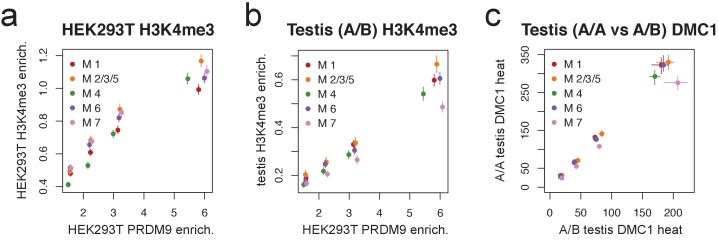
Motif 7 represents a binding mode favored by the B allele.(a) Peak enrichment quartiles (filtered to remove promoters) were separated by motif type (Motifs 2, 3, and 5 were combined due to low abundance), and mean force-called H3K4me3 enrichment was plotted against median PRDM9 enrichment in each quartile. Error bars indicate two standard errors of the mean. This shows that the lower recombination rates for Motif 7 do not result from lower histone methylation activity of PRDM9 at those sites. (b) Peak enrichment quartiles as in a, but with force-called testis H3K4me3 enrichment values from (Pratto et al., 2014) in an individual with an A/B genotype. Motif 7 shows lower testis H3K4me3 enrichment for each level of PRDM9 binding, consistent with it being bound less efficiently by the A allele. Error bars indicate two standard errors of the mean. (c) At DMC1 hotspots found in both A/A and A/B individuals (from Pratto et al., 2014), a q-q plot of reported DMC1 heats for each motif type (quantiles 0.125,0.375,0.625,0.875). Motif 7 peaks are relatively hotter in the A/B samples than in the A/A samples. Error bars represent 95% bootstrap confidence intervals.